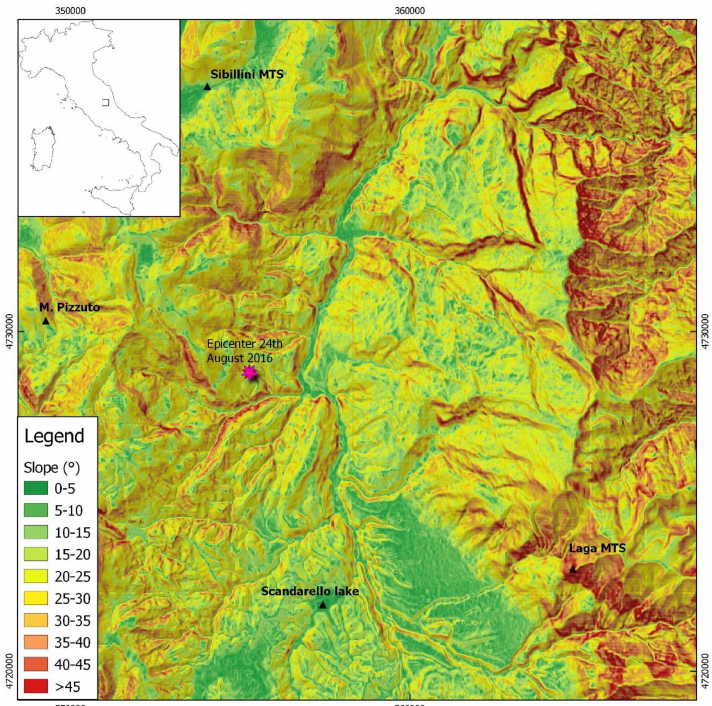
Figure A3. Slope map for the area of Figs.